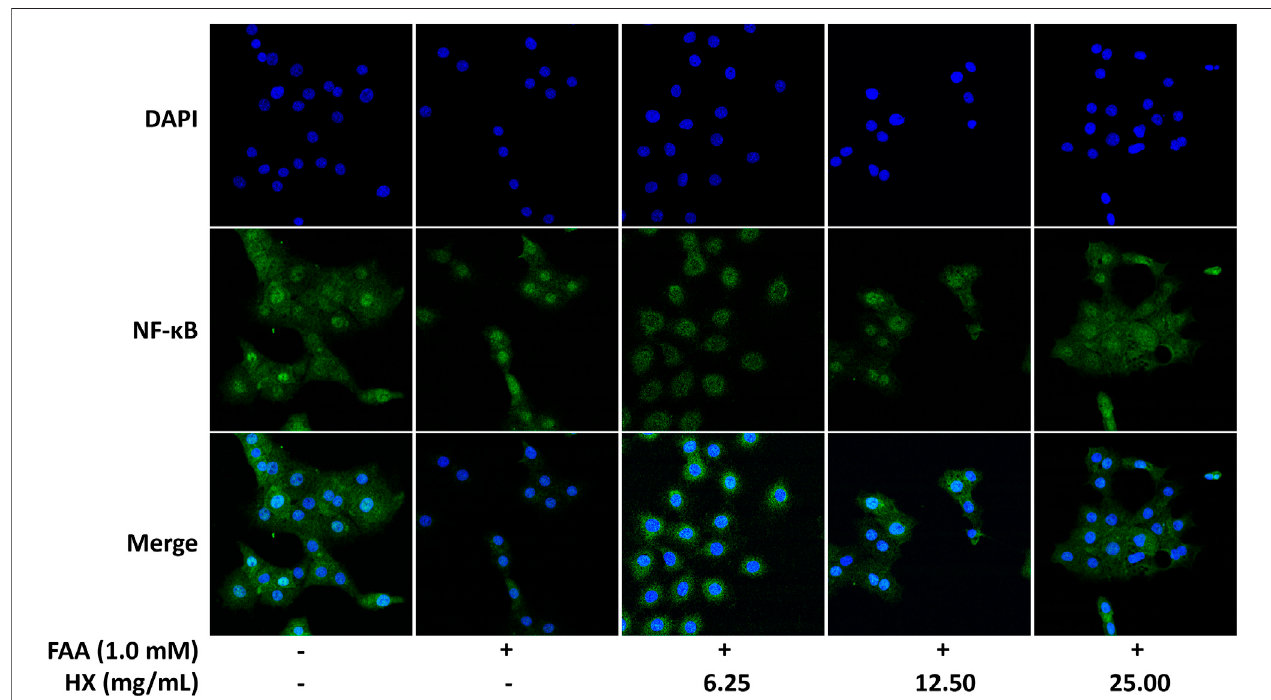
FIGURE 8 | Immuno fl uorescence images demonstrating nuclear staining (DAPI, blue; top images) , NF- κ B droplet staining (green; middle images) , and an overlay of both (merge, bottom images) in AML12 cells incubated without or with FFA and different concentrations of HX (6.25, 12.50, and 25.00 mg/ml). FFA, free fatty acid; HX, Huo